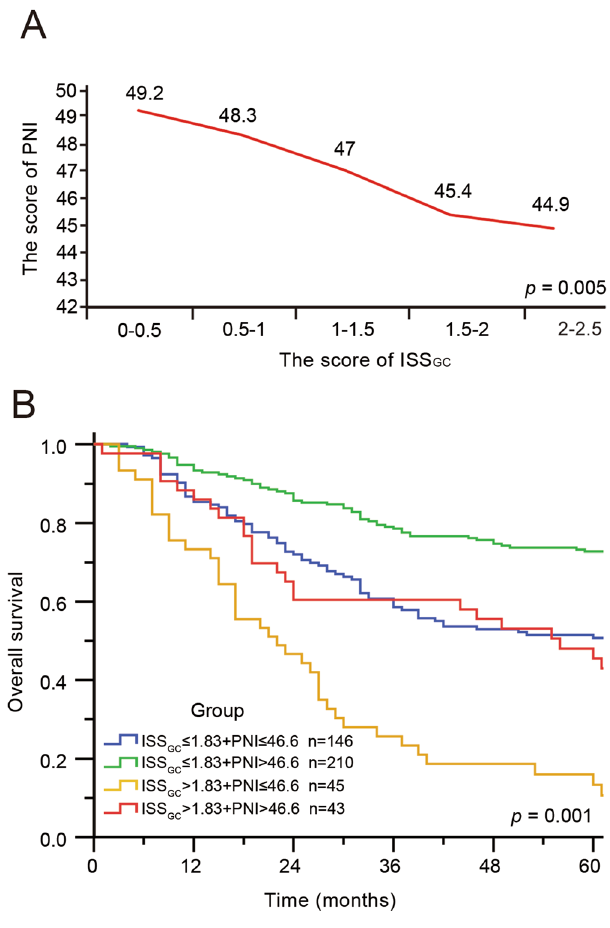
Fig. 6 The PNI is related to the ISS GC . A Negative correlation between the PNI and the ISS GC . Statistical signi fi cance was determined by a two-tailed paired Student ’ s t -test. B Four groups were created according to the cut-off points of the ISS GC and the PNI, and the overall survival in GC patients of these four groups was evaluated by Kaplan – Meier curves. p -Values for survival analyses have been calculated using the log-rank